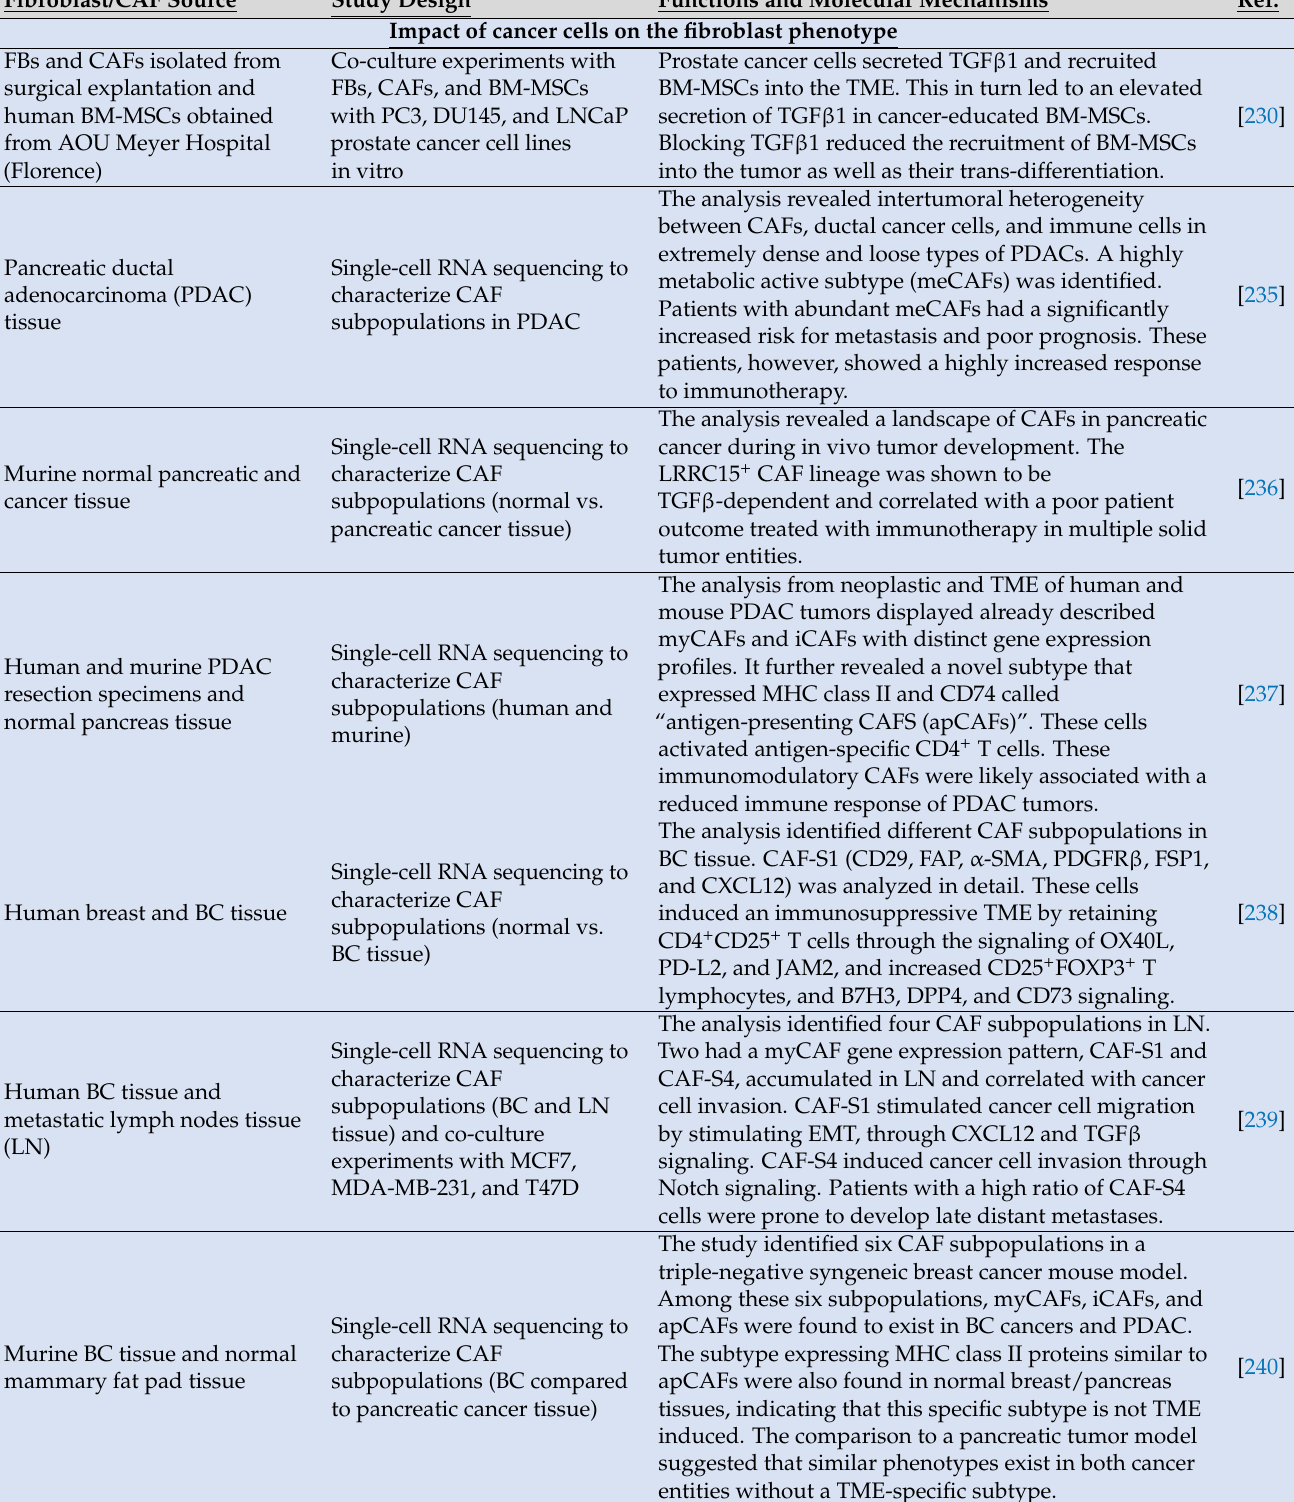
Table 2. Subtypes of CAFs in different cancer